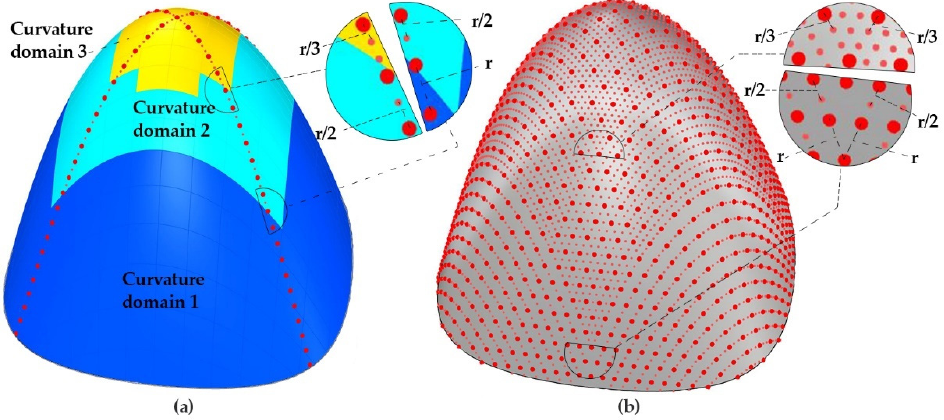
Figure 12. Adaptative Compass Method: ( a ) Surface curvature domains and subdivision of master curves; ( b ) Resulting net of points.